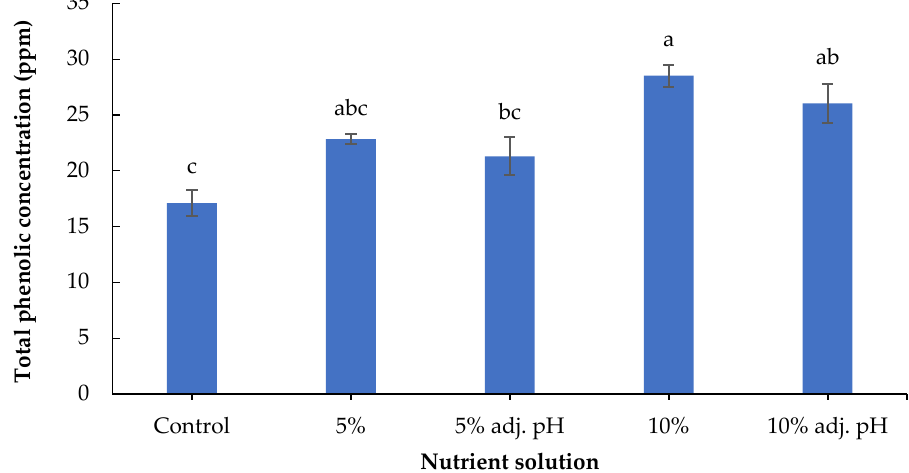
Figure 6. Total phenolics of baby lettuce leaves grown in a floating hydroponic system under different dilutions in water during the winter period. Columns (means ± SE) with different letters are significantly different ( p < 0.05).